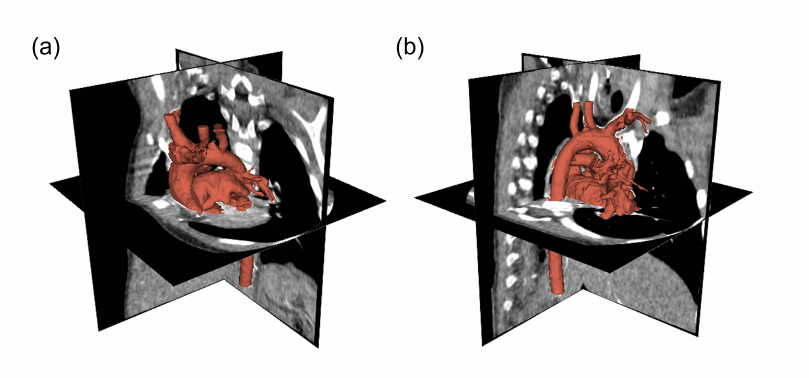
Figure 2. Segmentation on CT data of the MBTS case: front view ( a ) and back view ( b ).